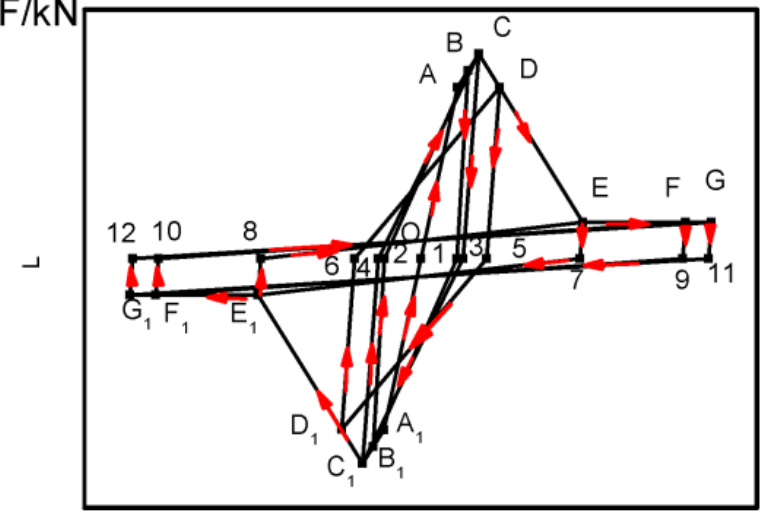
Figure 11. Restoring force model.